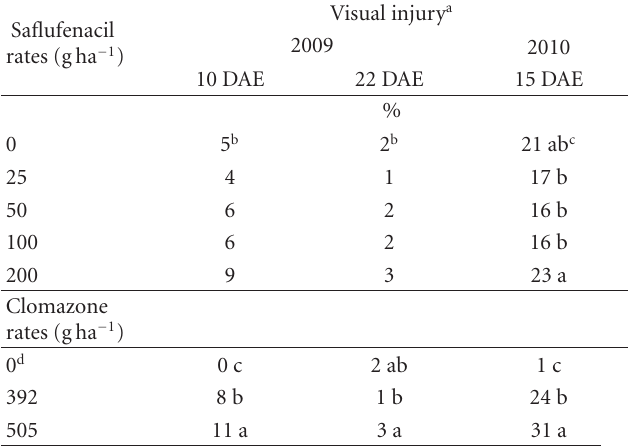
Table 2: Rice ( Oryza sativa L.) visible injury at 10 days after emergence (DAE) and 22 DAE in 2009 and 15 DAE in 2010 in response to saflufenacil and clomazone applied preemergence. Saflufenacil results were averaged across clomazone rates, and clomazone results were averaged across saflufenacil rates.